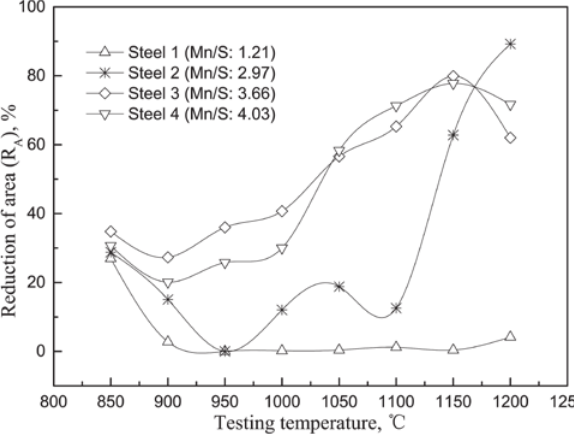
Fig. 1: Hot ductility curves of all tested steels